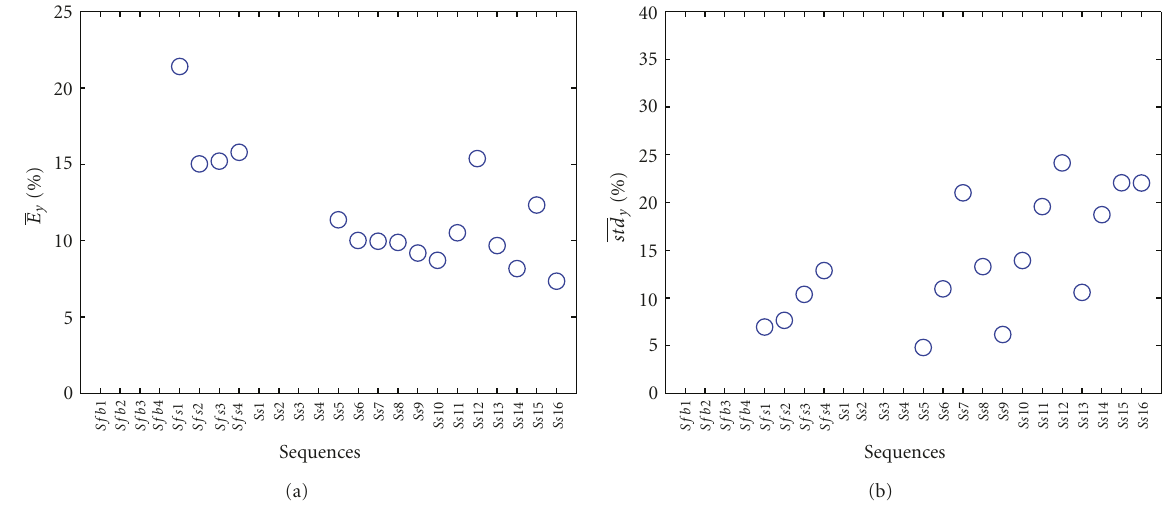
Figure 10: For each sequence, (a) normalized mean error E y , (b) normalized mean standard deviation std y